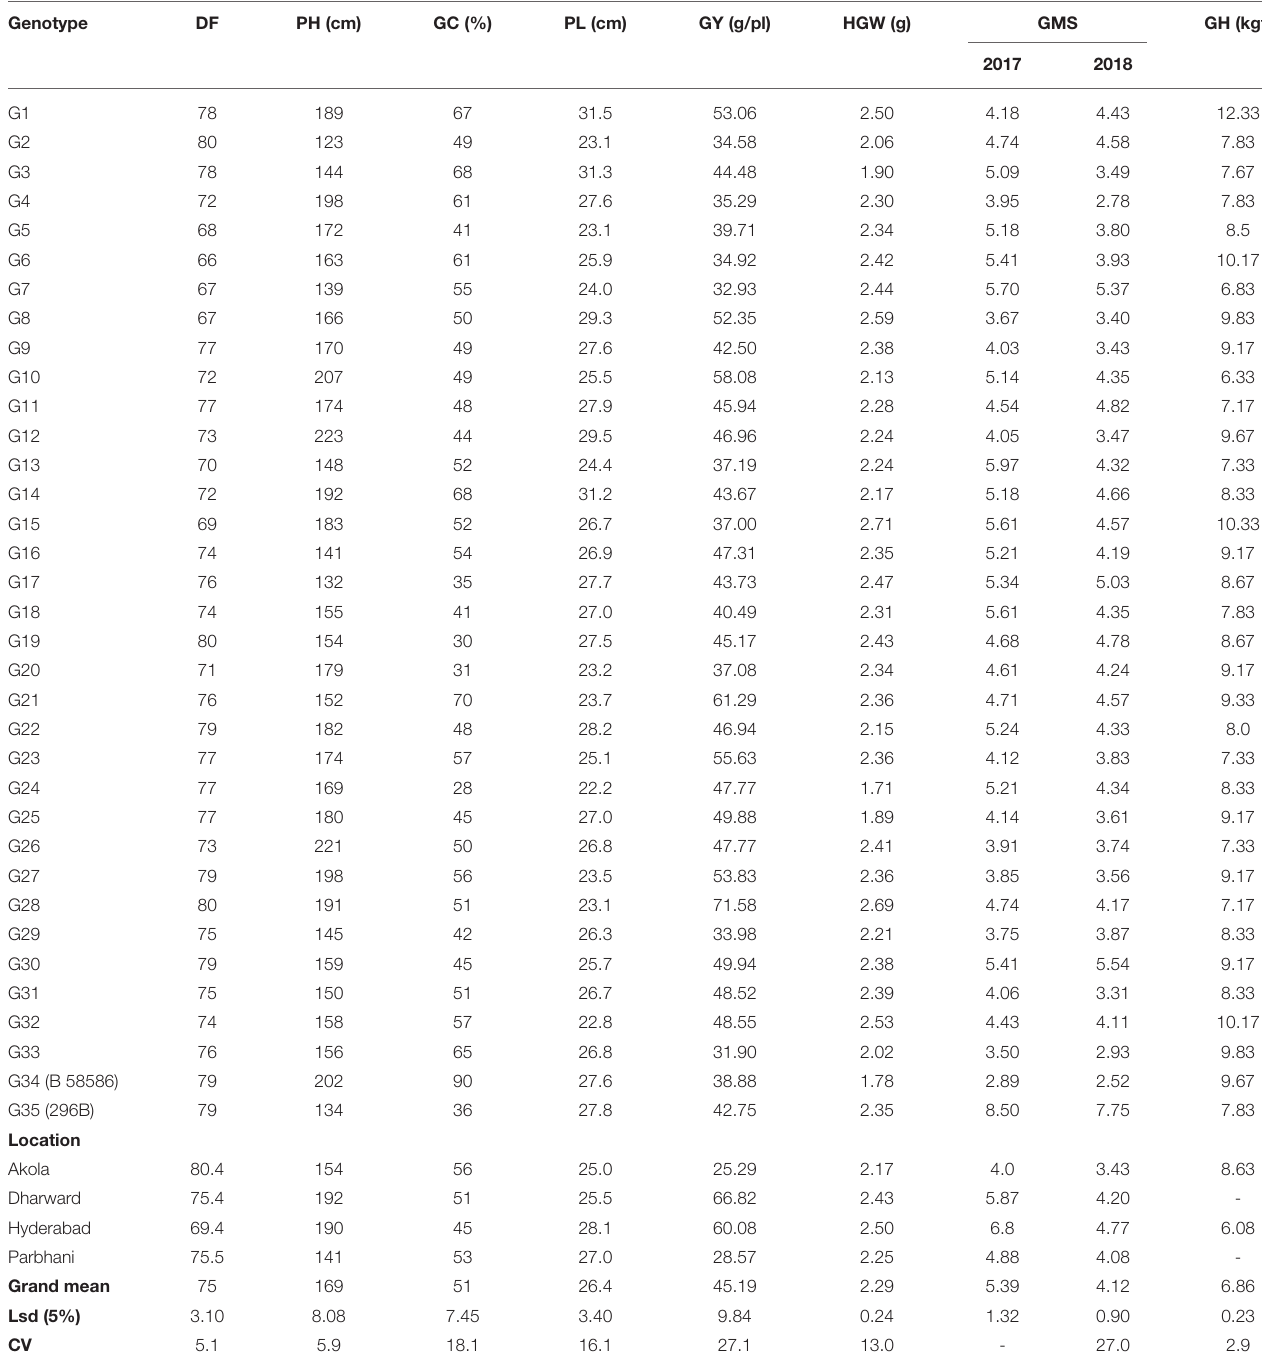
TABLE 3 | Per se performance of genotypes for all traits across locations during the rainy seasons of 2017 and 2018.